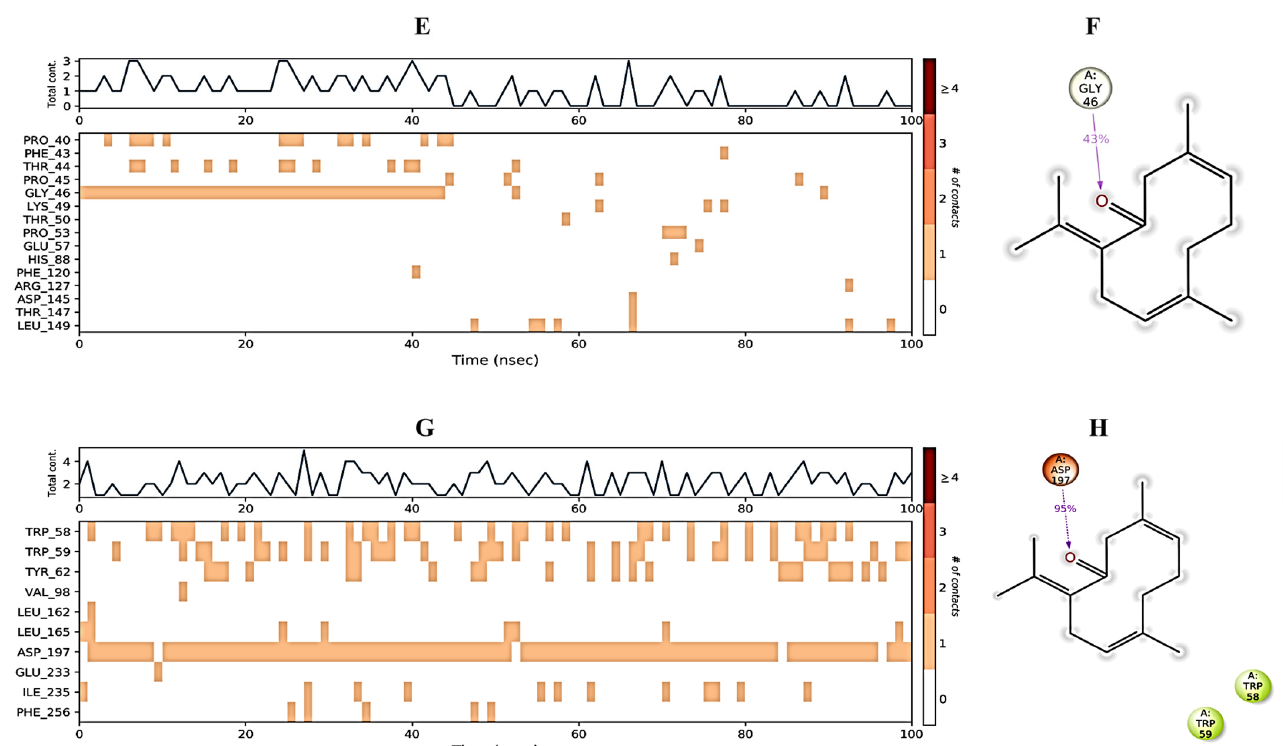
Figure 7. Protein–ligand contact. ( A , C , E , G ) The total number of specific protein–ligand contacts over the course of the trajectory. ( B , D , F , H ) Residues of 1EA1, 1IYL, 1HD2, and 1HNY proteins interacting with the ligand in each trajectory frame,